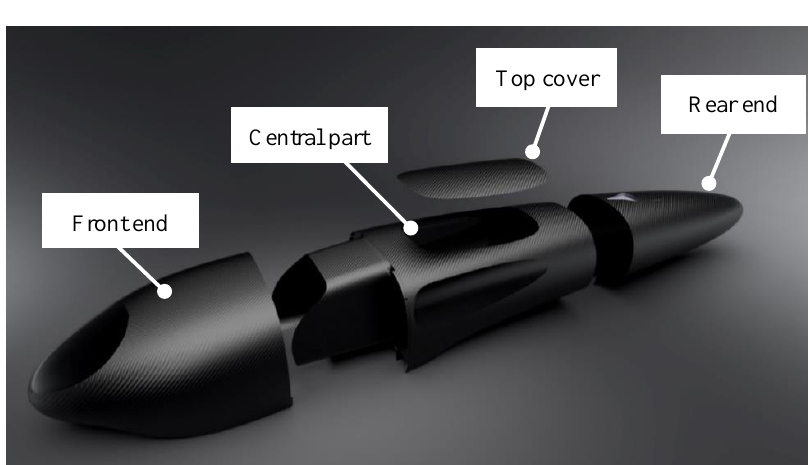
Figure 3. Subdivisions of the IDRAkronos’ body.